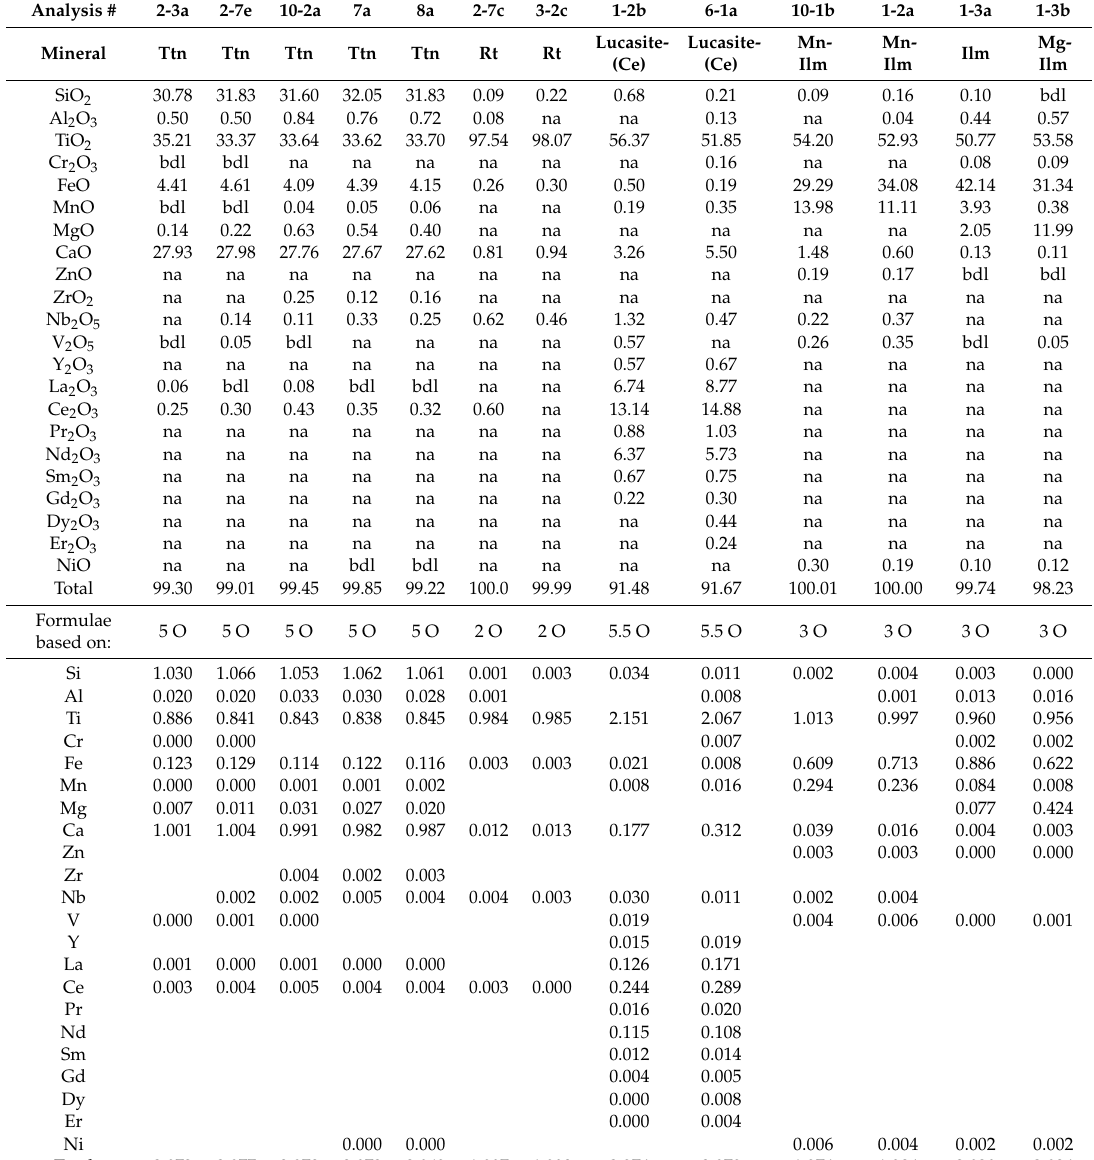
Table 5. Representative chemical compositions (wt.%) and mineral formulae (apfu) of titanite, ilmenite, rutile and lukasite-(Ce) from the Vinoren aillikite.